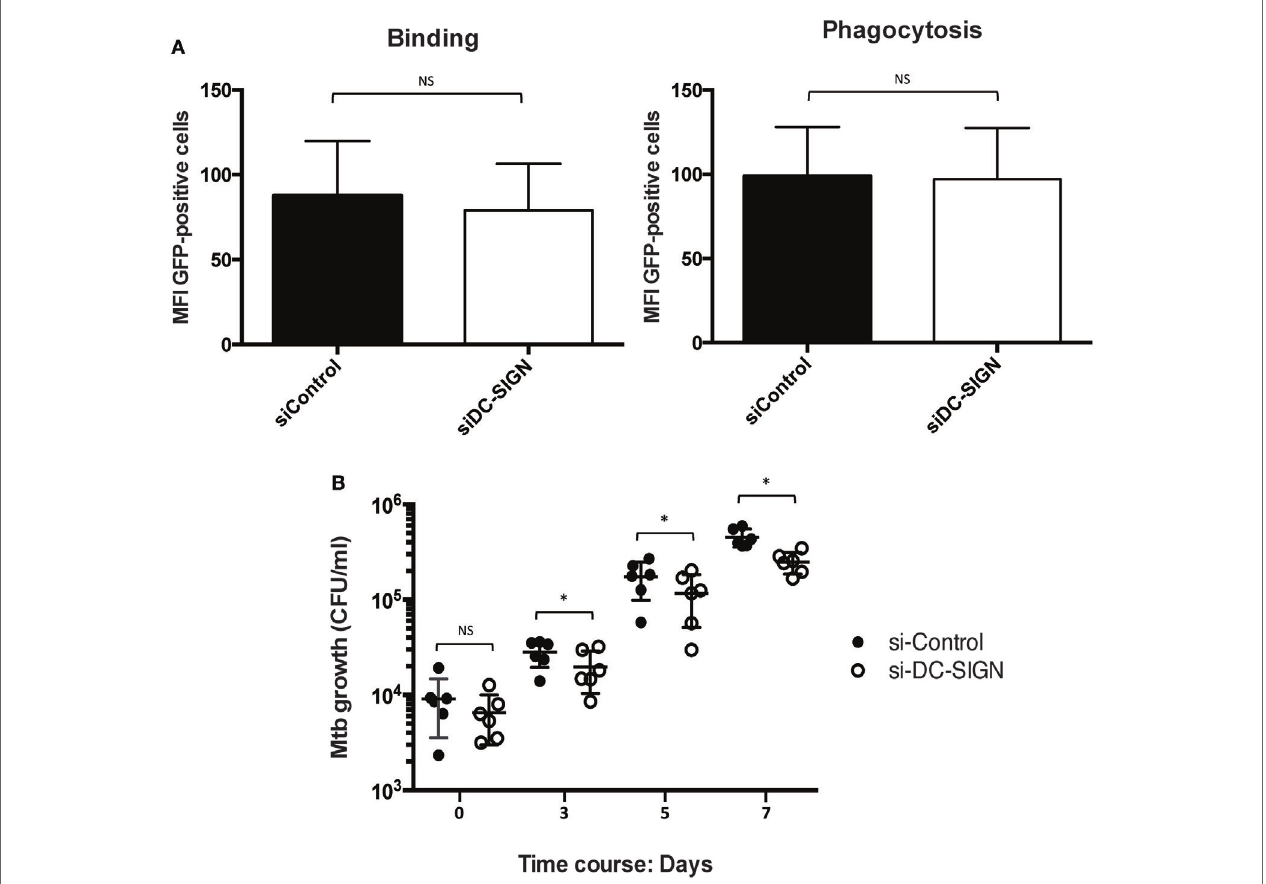
FigUre 4 | Different roles for DC-SIGN in the M(IL-4) macrophage–Mtb interaction. Human monocytes were differentiated into macrophages using M-CSF. At day 5, macrophages were transfected with siRNA targeting DC-SIGN (siDC-SIGN, white) or a non-targeting siRNA (siControl, black). The following day, the cells were activated for 48 h with IL-4 (20 ng/ml) to induce M(IL-4) program. ( a) DC-SIGN expression in M(IL-4) macrophages is redundant for the binding and internalization of Mtb. Control and DC-SIGN-depleted macrophages were tested for the capacity to bind (at 4°C, left) or phagocytose (at 37°C, right) the Mtb strain expressing GFP during 4 h of challenge. Bar graphs illustrate the median fluorescent intensity (MFI) of cells positive for GFP, as measured by flow cytometry analysis. Results are expressed as mean ± SD ( n = 4 donors). NS, not significant. (B) DC-SIGN influences the capacity of M(IL-4) macrophages to control the Mtb intracellular burden. The cells were infected with Mtb (MOI of 0.2 bacteria to 1 cell) and the intracellular growth of the bacteria was followed at 4 h (day 0), 72 h (day 3), 120 h (day 5), and 168 h (day 7), as measured by colony forming unit (CFU) assays. Results are expressed as vertical scatter plots showing the CFU scoring per ml; each circle represents a single donor. Two-tailed Wilcoxon (matched-paired/nonparametric): *P < 0.05; NS, not